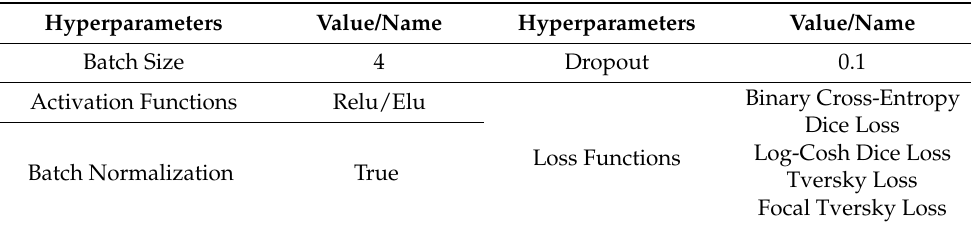
Table 6. Hyperparameters and their corresponding values.